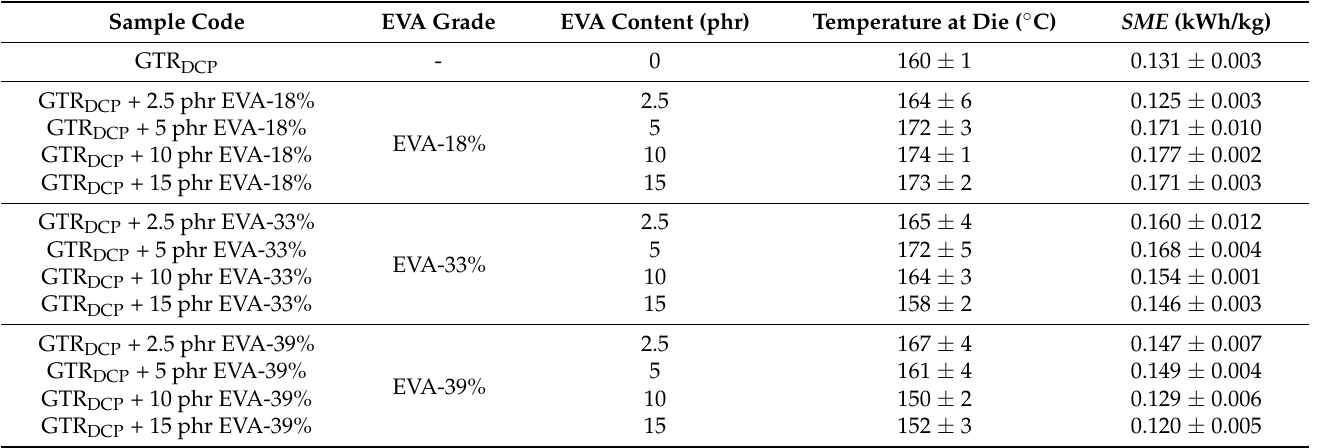
Table 3. Temperature and specific mechanical energy consumption measured during modification of